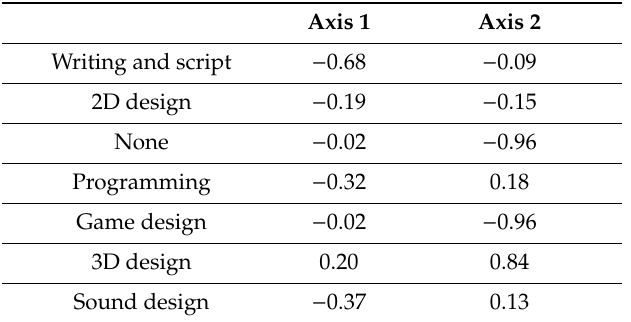
Table 9. Coordinates column of education and